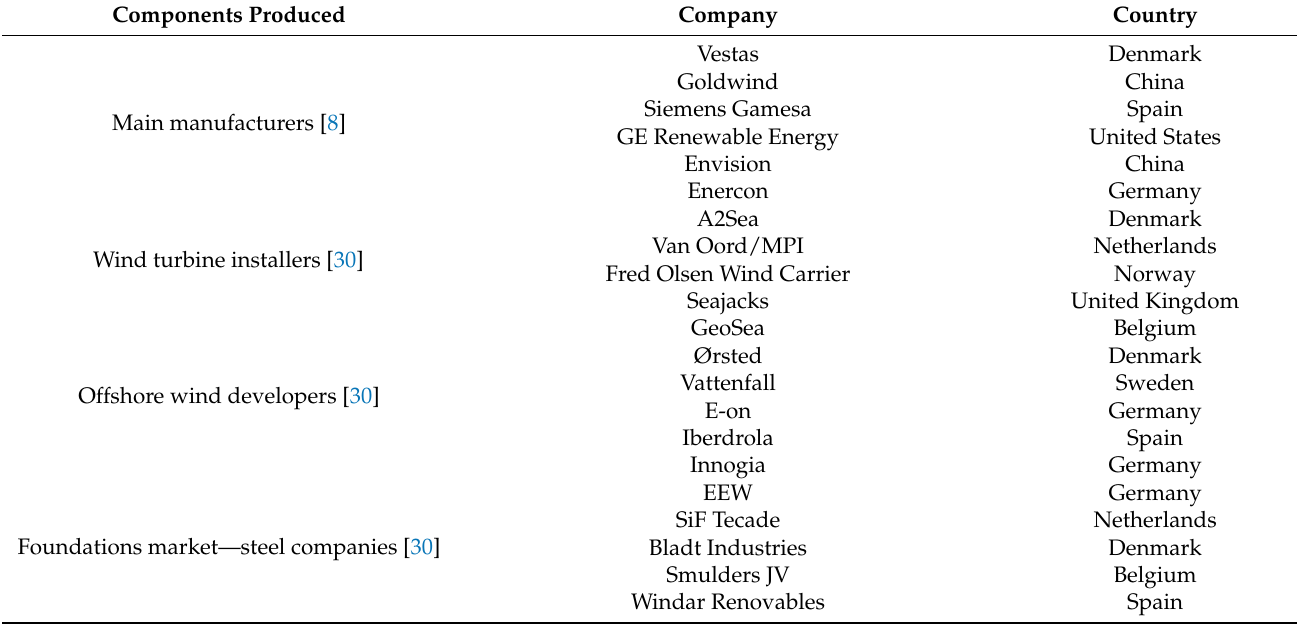
Table 2. The main companies in the offshore wind turbine